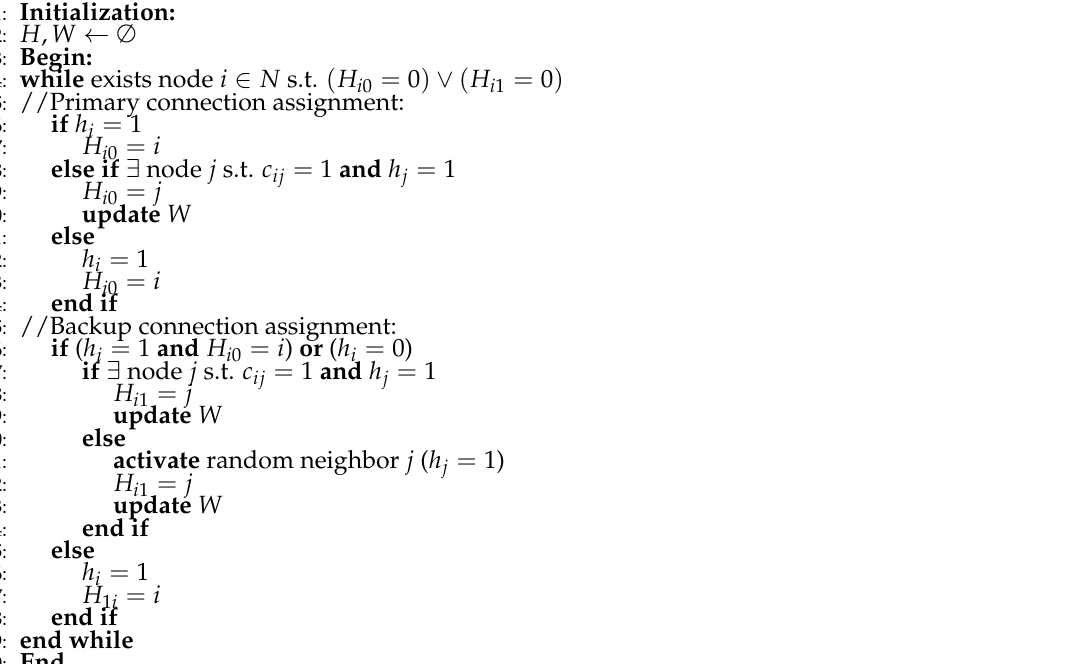
Algorithm 1 C-RAN reliable coverage (phase